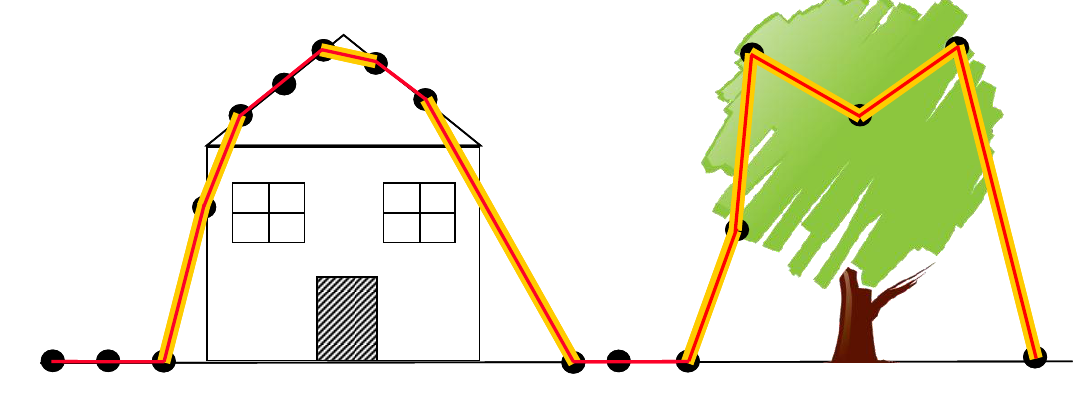
Figure 4. Exceptions where the TIN patches will not represent the physical surface (highlighted in